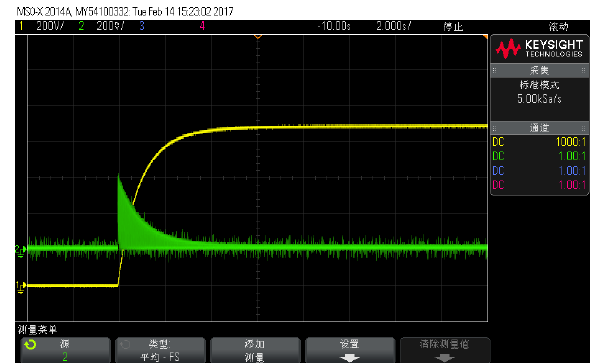
Fig. 8. The capacitor charging waveform with the soft- start resistor.